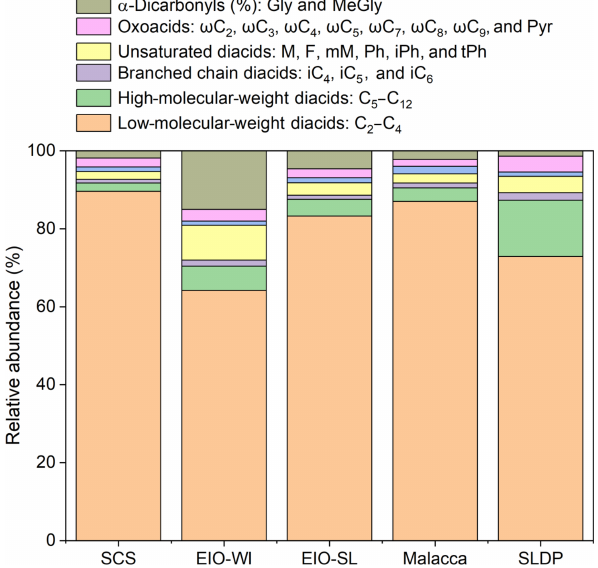
Figure 5. Relative abundances of individual compound classes in the total diacids, oxoacids, and α -dicarbonyls in aerosols from dif- ferent sampling areas collected during the NORC2015-10